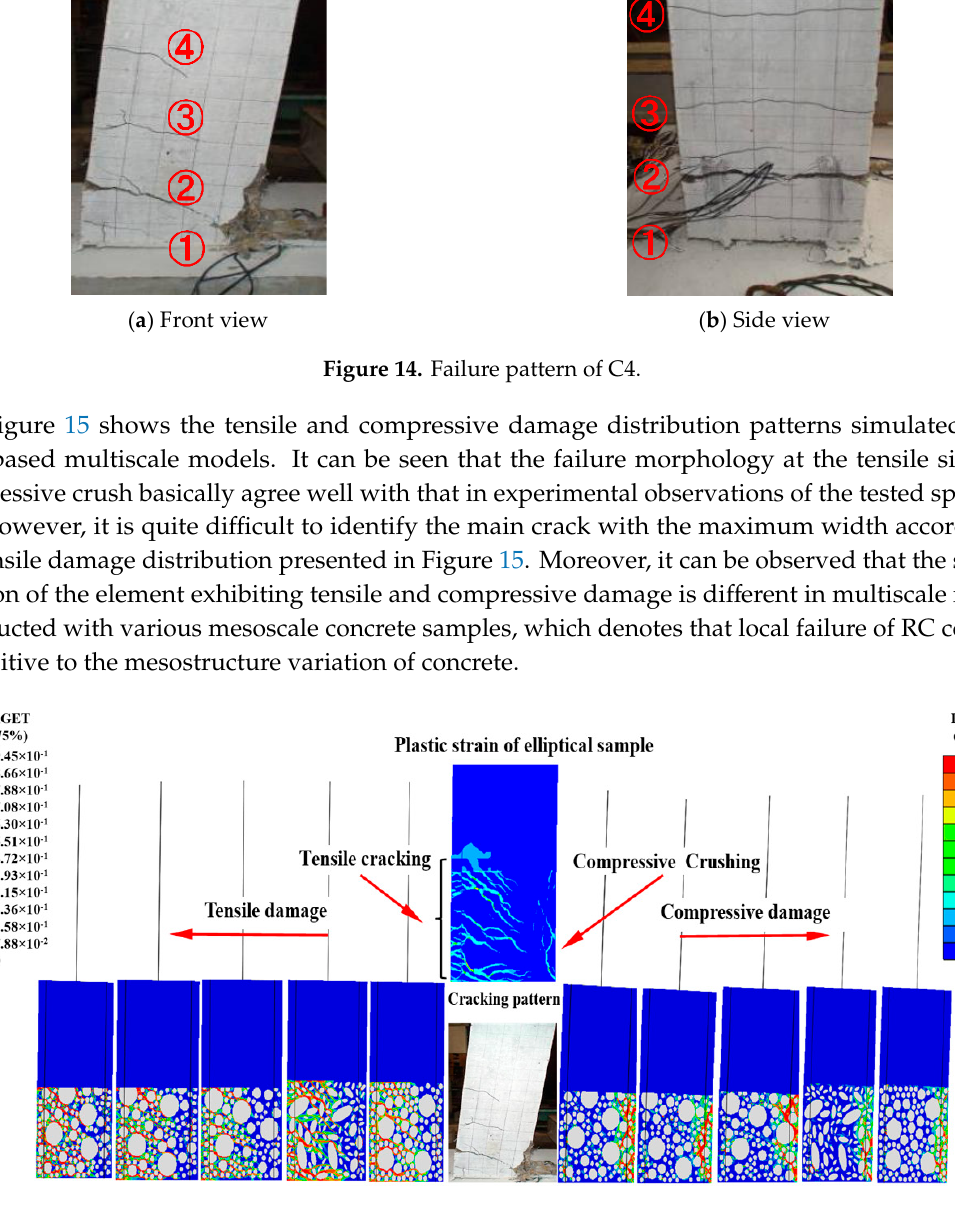
Figure 15. Damage pattern in CDP ‐ based multiscale models.